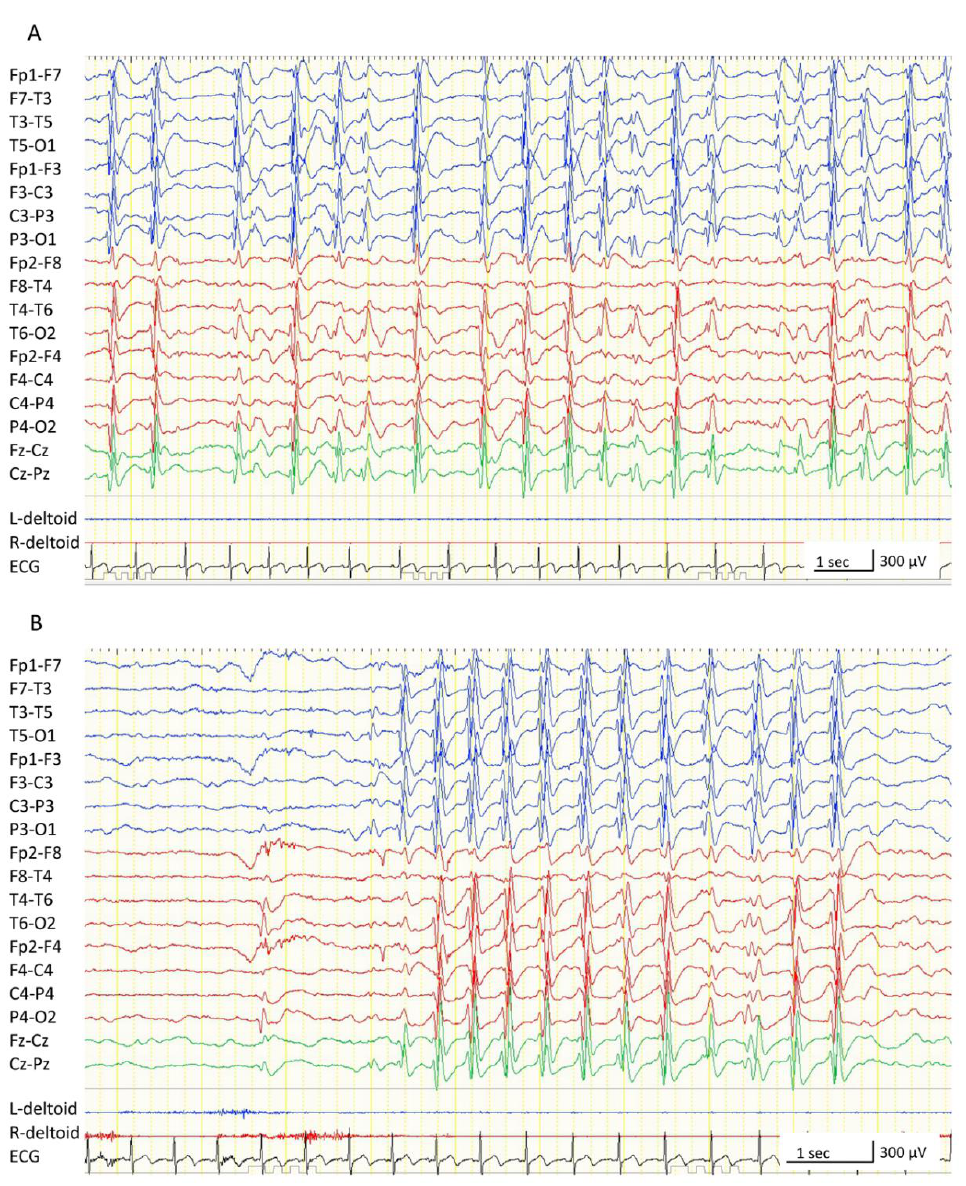
Figure 2. Scalp electroencephalogram (EEG) at 4 years of age. All EEGs were recorded with the following settings: low- cut filter, 1.6 Hz; high-cut filter, 60 Hz. ( A ) Interictal sleep EEG. Continuous epileptiform discharges are observed predominantly in the left hemisphere. ( B ) Ictal EEG of an absence seizure. 2.5- to 3 Hz spike and wave discharges in the left parieto-occipital region precede the generalized spike and wave discharges compatible with ictal EEG characteristics of absence seizures.